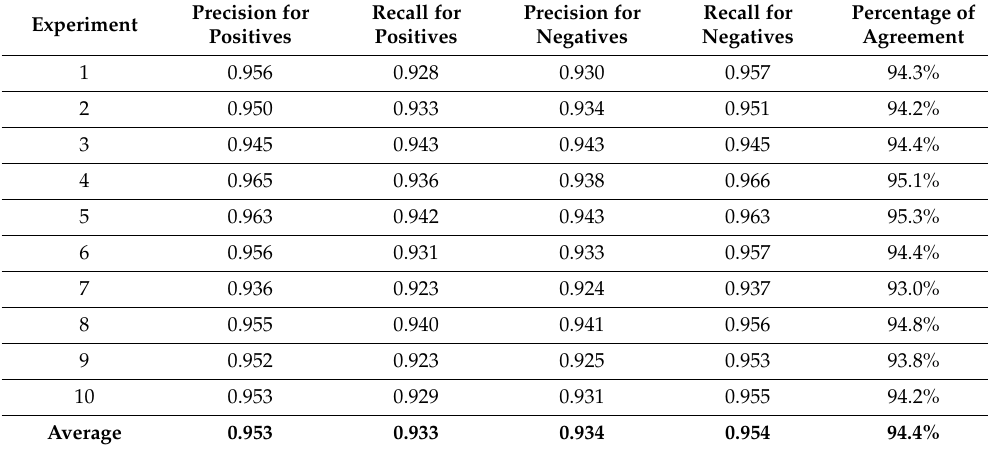
Table 3. Summary of the results of the classifiers obtained with the 10 experiments: precision, recall and percentage of agreement in classifying images as UML static diagrams.